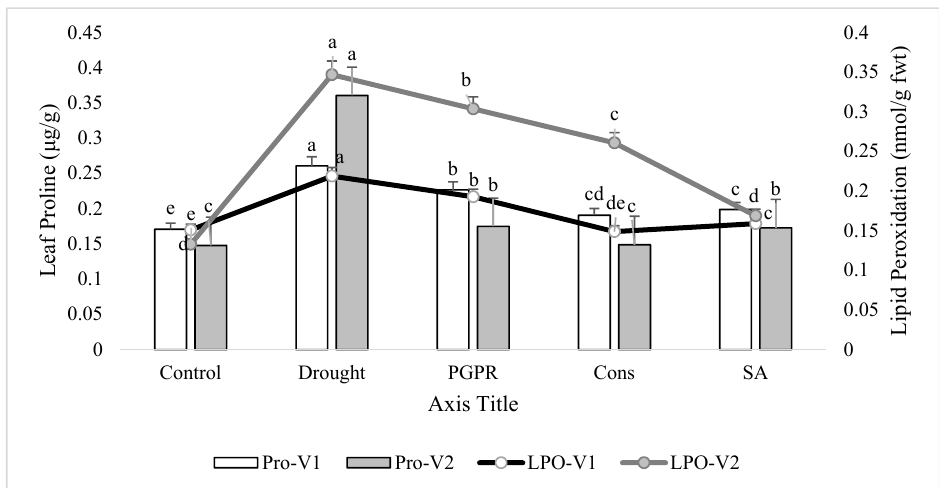
Figure 3. Leaf proline content and lipid peroxidation in the leaves of drought sensitive and tolerant varieties grown under rainfed conditions. V1: drought sensitive variety; V2: drought tolerant variety; Pro: proline; LPO: lipid peroxidation. Different significance levels were denoted with different letters (a, b, c, d and e).